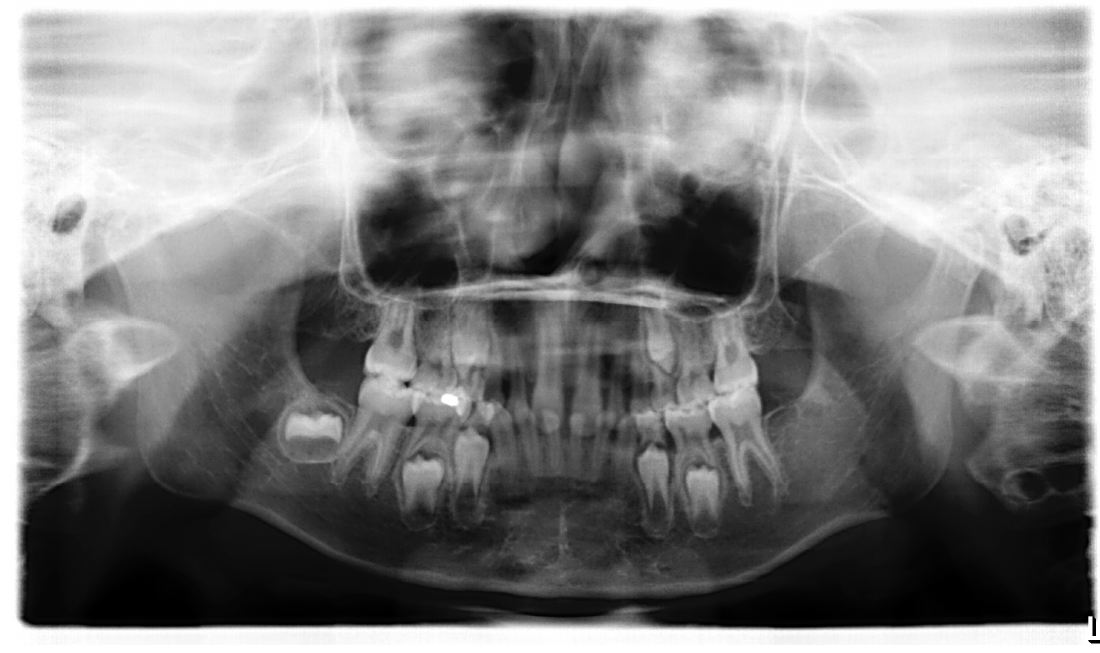
Figure 2. Panoramic radiograph of proband in family 7. He did not have any missing primary teeth congenitally (#51 and #61 had replaced by #11 and #21). However, 15 teeth were missing in the permanent dentition. Table 1. Summary of clinical data and mutations in EDA , EDAR, and WNT10A genes in family 1–7.